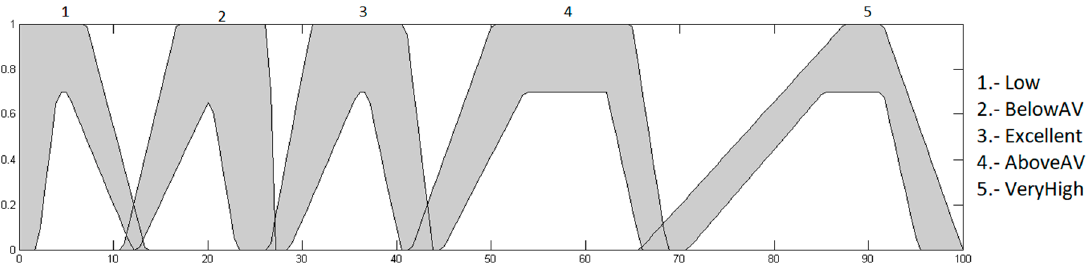
Figure 27. Optimized output heart rate level with trapezoidal MFs.